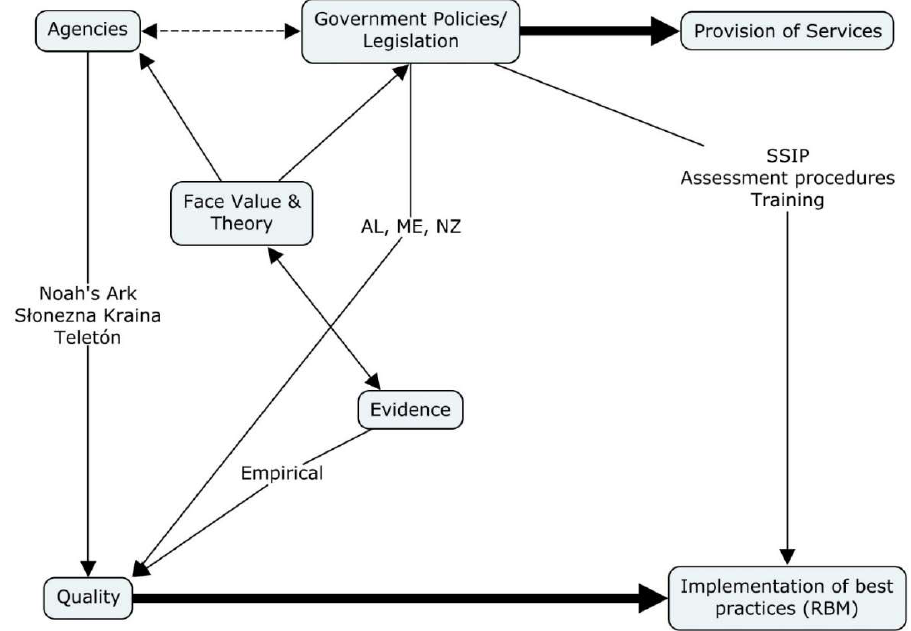
Figure 3. Relationships among government, evidence, and implementation. AL: Alabama: ME: Maine, NZ: New Zealand. RBM: Routines-Based Interview.